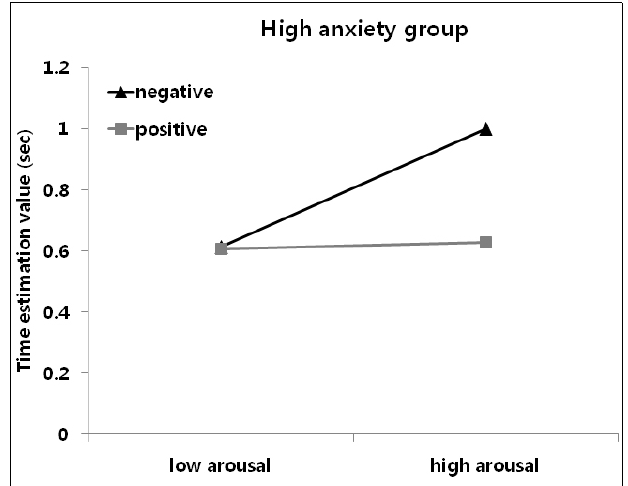
FIGURE 1 | Time estimation value (modified T -Corrected) for each